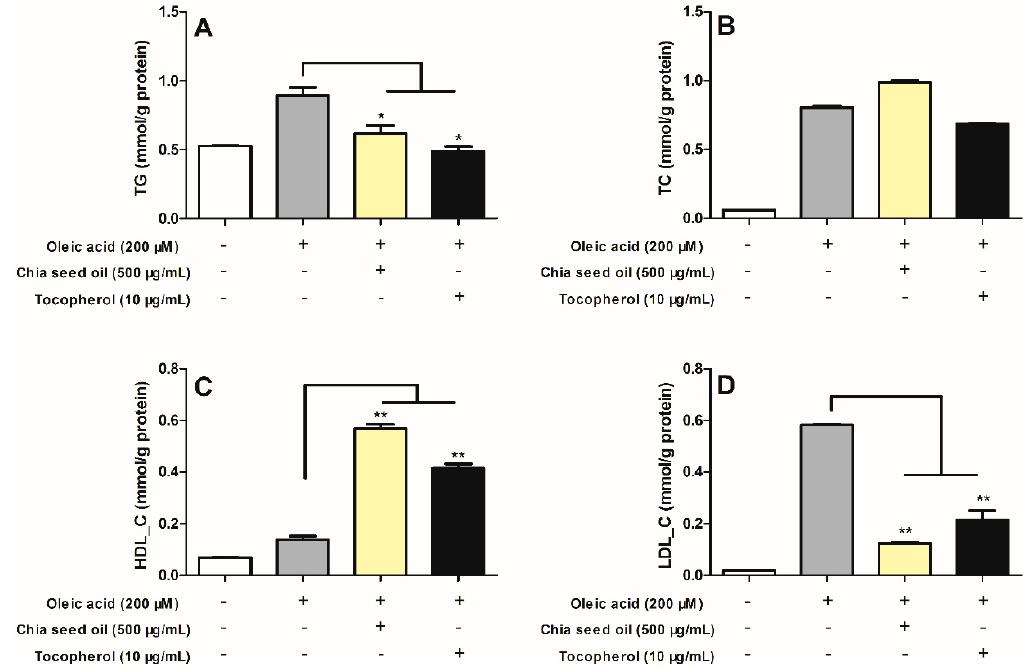
Figure 2. Effects of chia seed oil on accumulation of the intracellular ( A ) TG, ( B ) TC, ( C ) HDL-C, and ( D ) LDL-C in oleic acid (OA)-induced HepG2 cells. OA-induced accumulation of TG and LDL-C was significantly reduced by chia seed oil co-treatment in HepG2 cells. Vertical bars represent the mean ± SE of three independent experiments. * p < 0.05, ** p < 0.01 versus OA group.